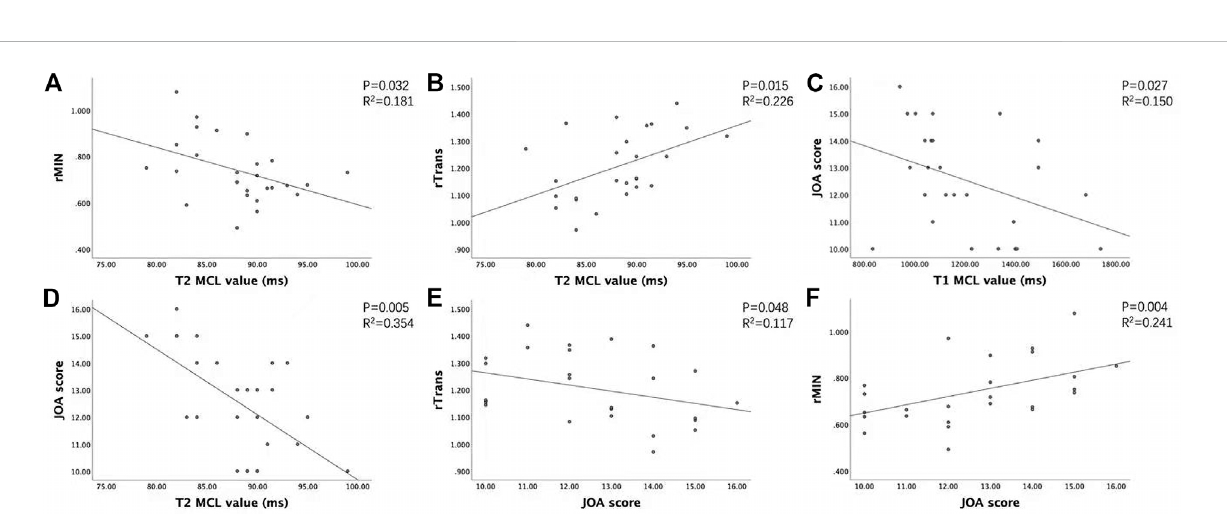
Figure 4. Multilevel correlations were observed in the CSM patients of grade II and III. T1 MCL and T2 MCL values were all negatively correlated with JOA scores. T2 MCL value was negatively correlated with rMIN, whereas positively correlated with rTrans. Conversely, JOA score was negatively correlated with rTrans, whereas positively correlated with rMIN (Figure 5).